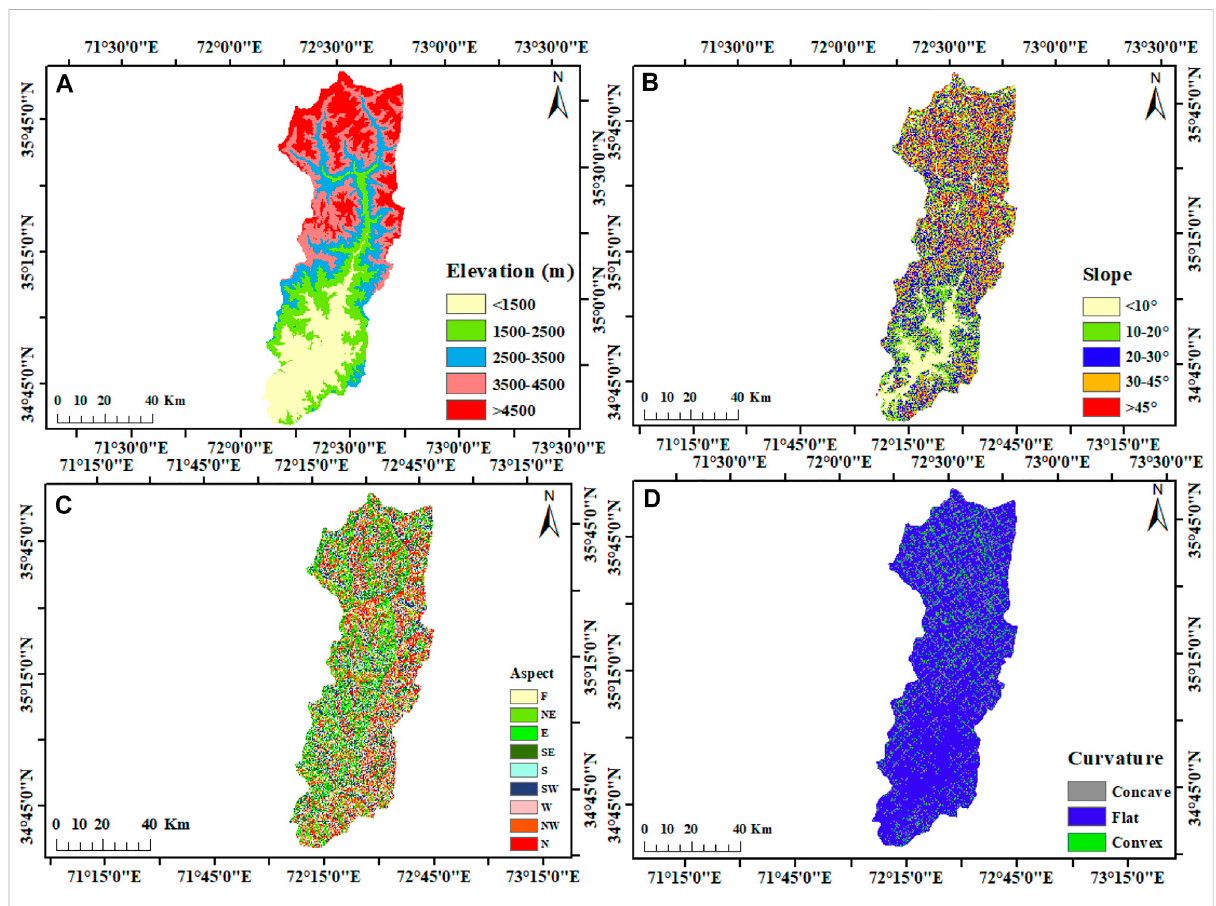
FIGURE 4 Topographic parameters derived from DEM for LSM: (A) elevation map; (B) slope map; (C) aspect map; (D) curvature map for the study